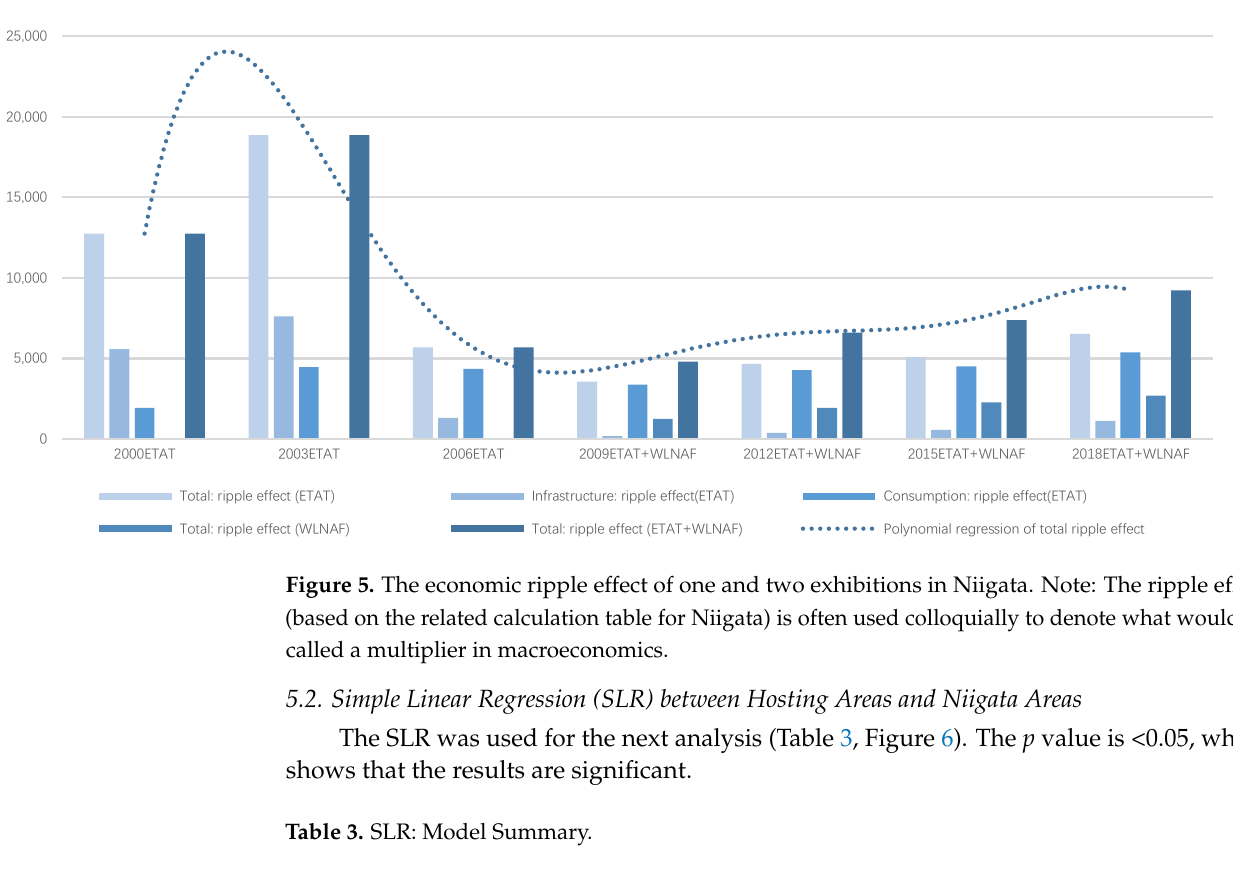
Figure 4. Tourist number and growth rate of the ETAT and WLNAF from 2000 to 2018 [10].